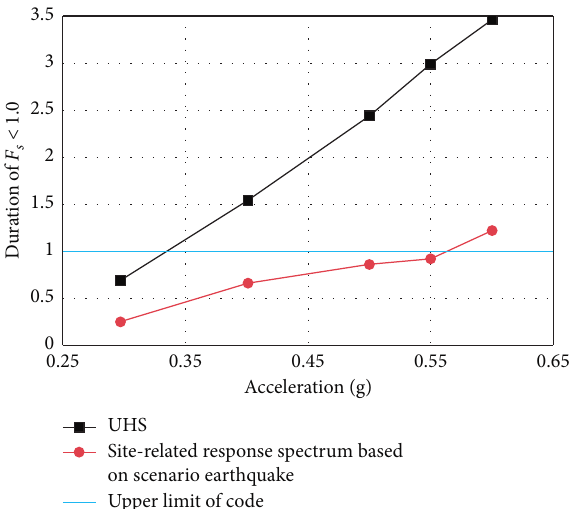
Figure 13: Duration for which the safety factor Fs is below 1.0 using different response